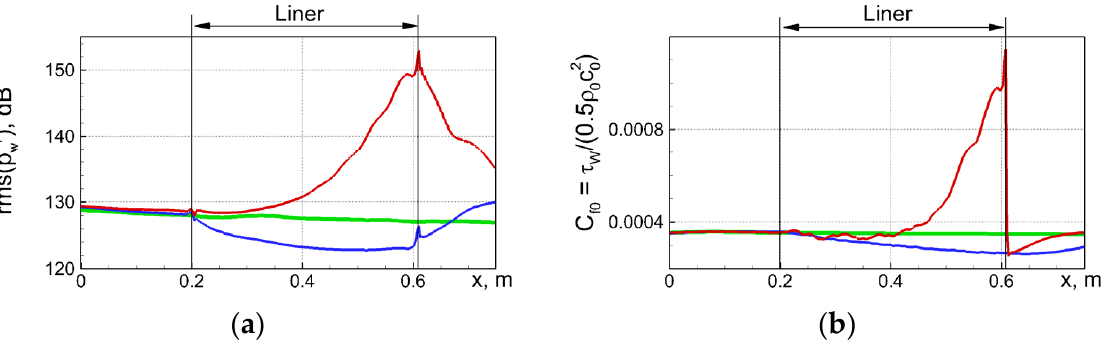
Figure 11. Same as in Figure 10, for streamwise distributions of root-mean-square wall-pressure fluctuations ( a ) and mean friction coefficient ( b ).